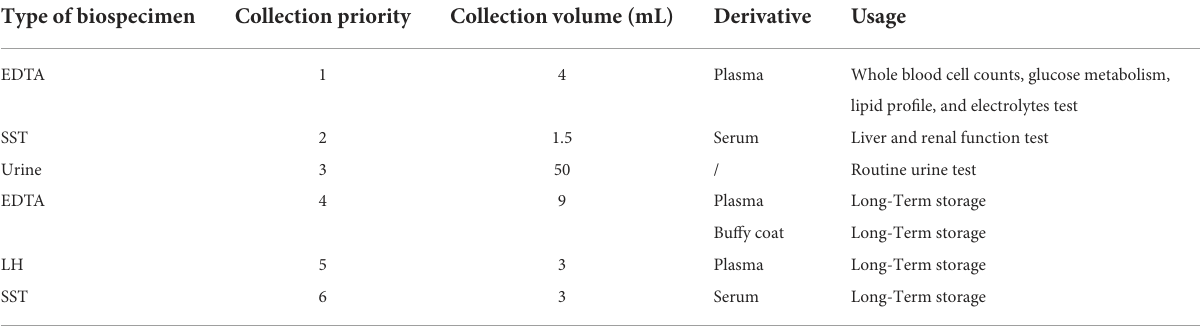
TABLE 1 Type of biospecimen, collection priority, and